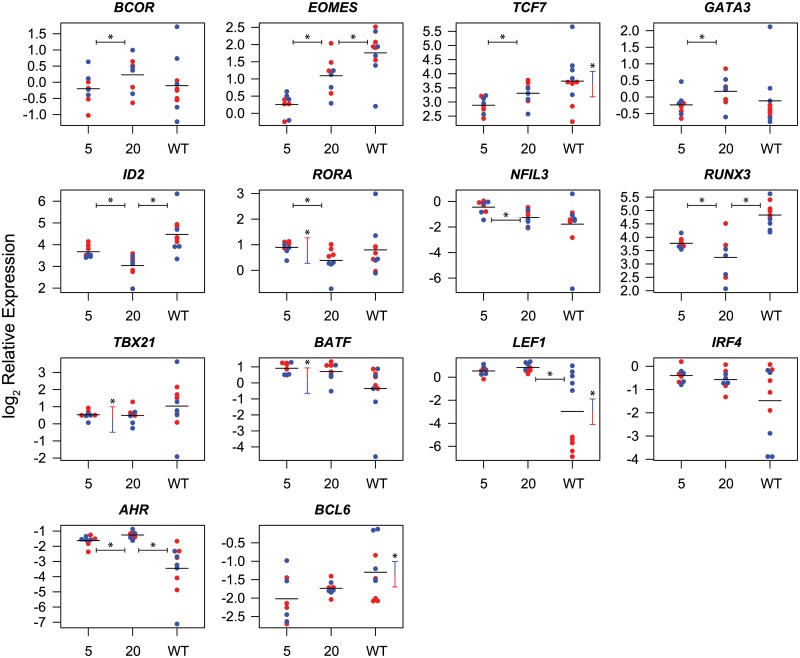
Differential expression of transcription factors in CD8+ T cells isolated at week 5 and week 20 post-vaccination with SIVΔnef and at week 20 post-infection with wild-type SIV.Symbols indicate log2 expression relative to endogenous controls in cells from individual animals. Red symbols indicate Gag CM9-specific cells, blue symbols indicate Tat SL8-specific cells. Sample means are indicated by horizontal bars. Statistically significant (p≤0.05) differences in transcription factor expression between cells from week 5 and week 20 post-SIVΔnef vaccination, or between cells from week 20 post-SIVΔnef vaccination and week 20 post-wild-type SIV infection are indicated by horizontal bars with asterisks. Statistically significant differences between Gag CM9 and Tat SL8-specific cells are indicated by vertical bars with asterisks.